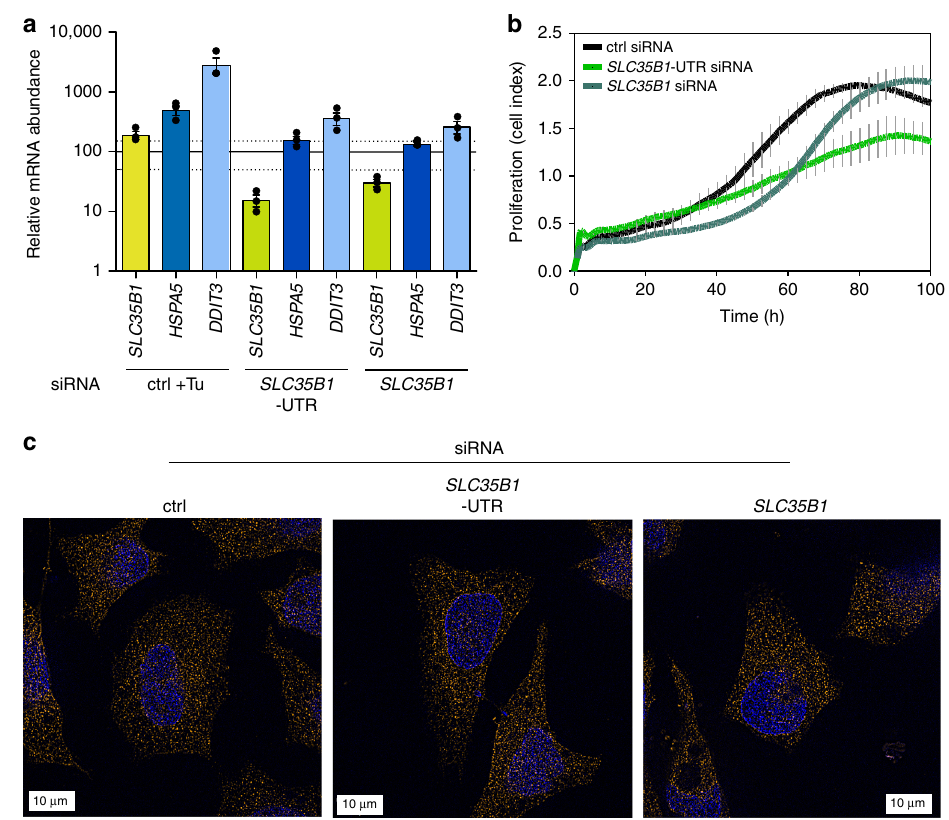
Fig. 5 SLC35B1 knockdown in HeLa cells does not dramatically affect cell growth, cell and ER morphology. a Quantitative RT-PCR performed after the transfection of HeLa cells with control siRNA or with SLC35B1 - or SLC35B1 -UTR targeting siRNA for 96 h. One set of control siRNA samples was treated with tunicamycin (Tu, 2.5 µ g/ml) for 2 h in order to induce UPR 40 . Data from three independent experiments are reported together with the individual data points as % of control with SEM. The light lines indicate the 50 and 150% values. The HSPA5 gene encodes BiP, the DDIT3 gene CHOP. b HeLa cells were transfected with control siRNA or with SLC35B1 -targeting or SLC35B1 -UTR-targeting siRNA for 48 h, transferred to xCELLigence plates (5 × 10 3 cells per well), and cultivated for 100 h. Cell growth was monitored in real-time. c HeLa cells were transfected with control siRNA or with SLC35B1 -UTR-targeting siRNA for 96 h, stained with DAPI and with a Sec62-speci fi c antibody, and analyzed on the super-resolution microscope 38 . Representative images are shown (scale bar 10 µ m)